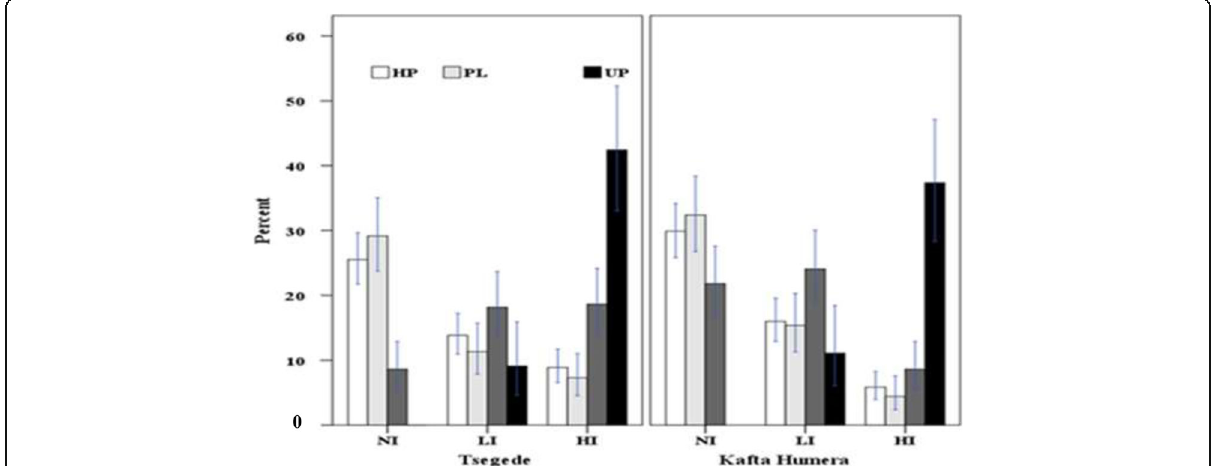
Fig. 3 Percentage of palatability of herbaceous vegetation (based on the frequency of occurrence; HP highly palatable, PL palatable, LP less palatable, UP unpalatable) under three Senna obtusifolia invasion levels (NI non-invaded, LI lightly invaded, HI heavily invaded) at Kafta Humera and Tsegede districts in northern Ethiopia. Bars indicate the SE of the